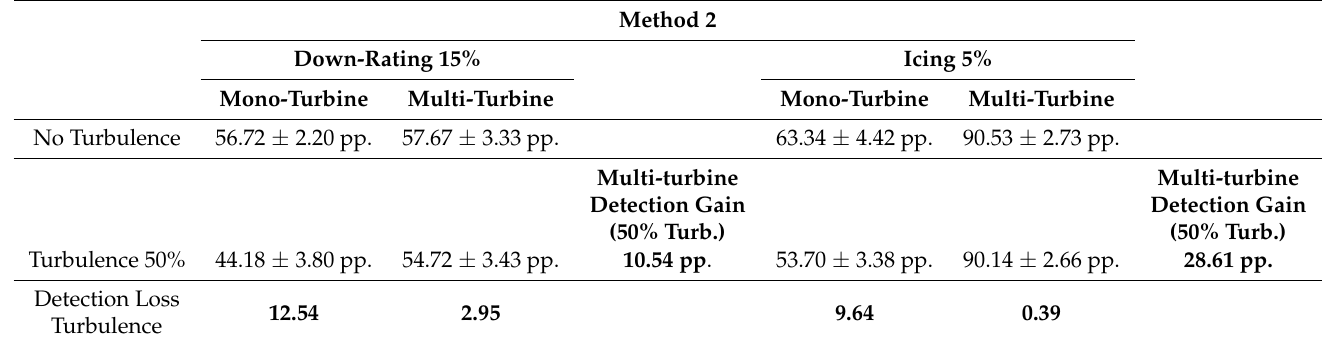
Table 3. Impact of turbulence on detection performance of Method 2—Mono and